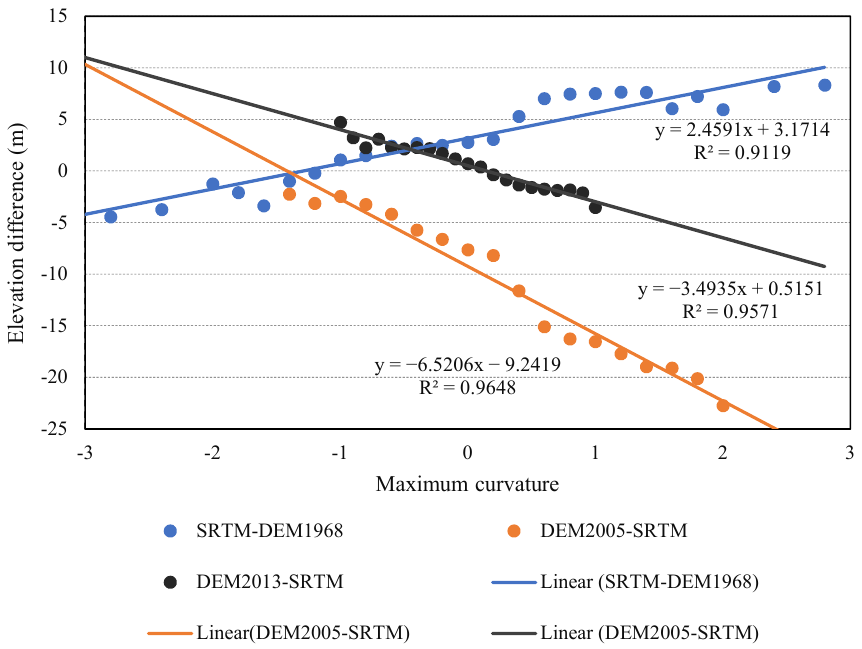
Figure 5. Elevation differences between SRTM band and DEM1968, DEM2005 and DEM2013 as a function of maximum curvature.